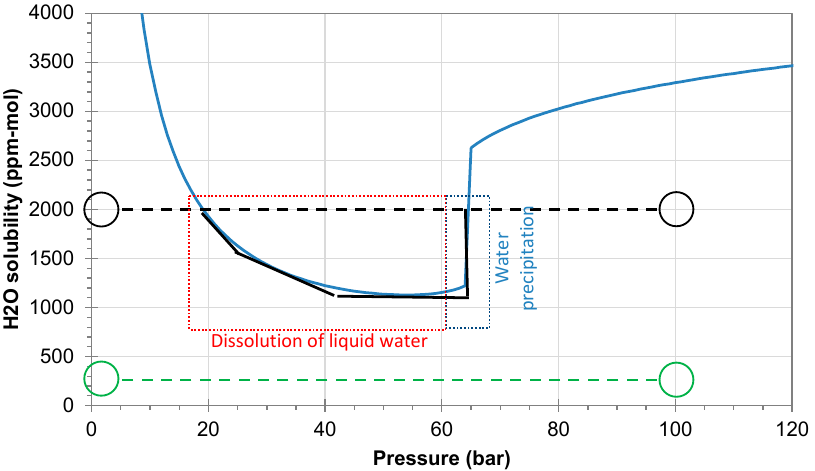
will be fully dissolved when the pressure reaches 20 bar.